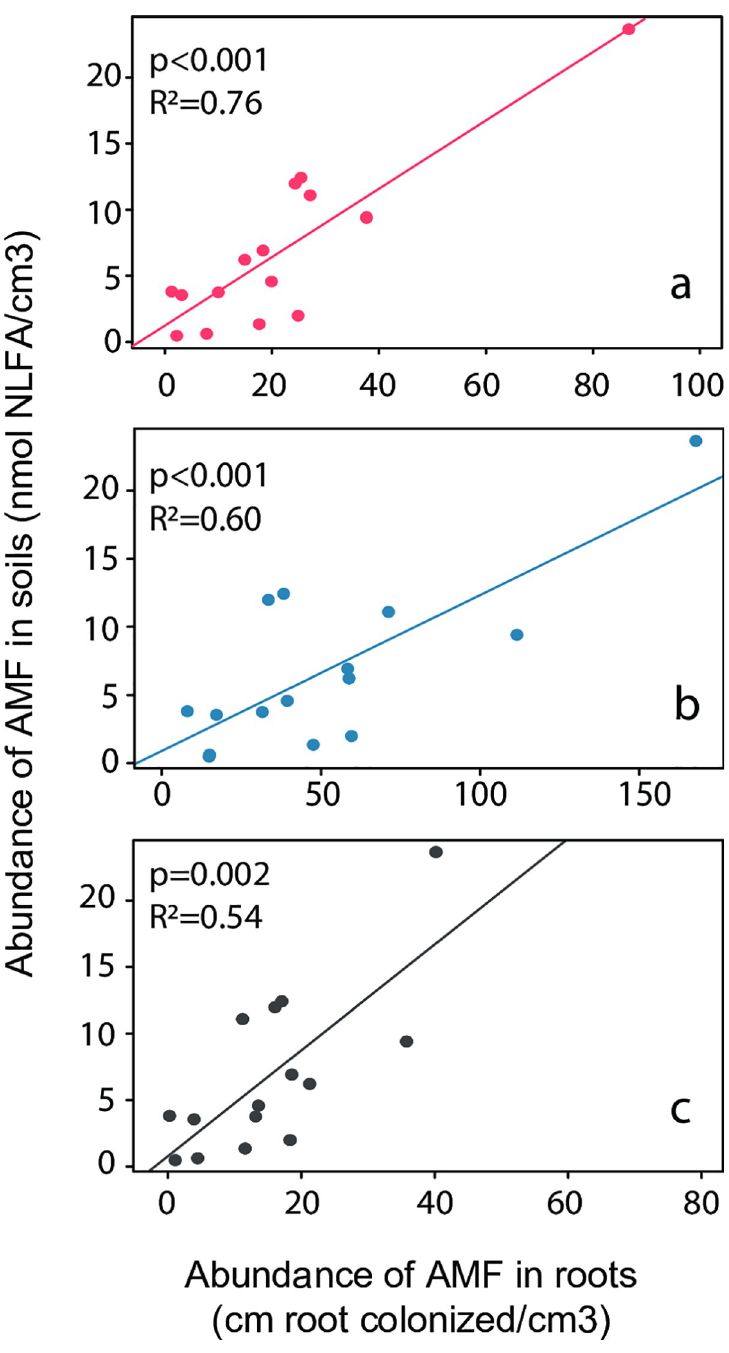
Fig 2. Linear relation between the AMF biomass in the soil and the total root length colonized for the three detected AMF structures. (a) arbuscules (b) hyphae and (c) vesicle. NLFA 16:1w5 was used as a proxy of the AMF biomass in the